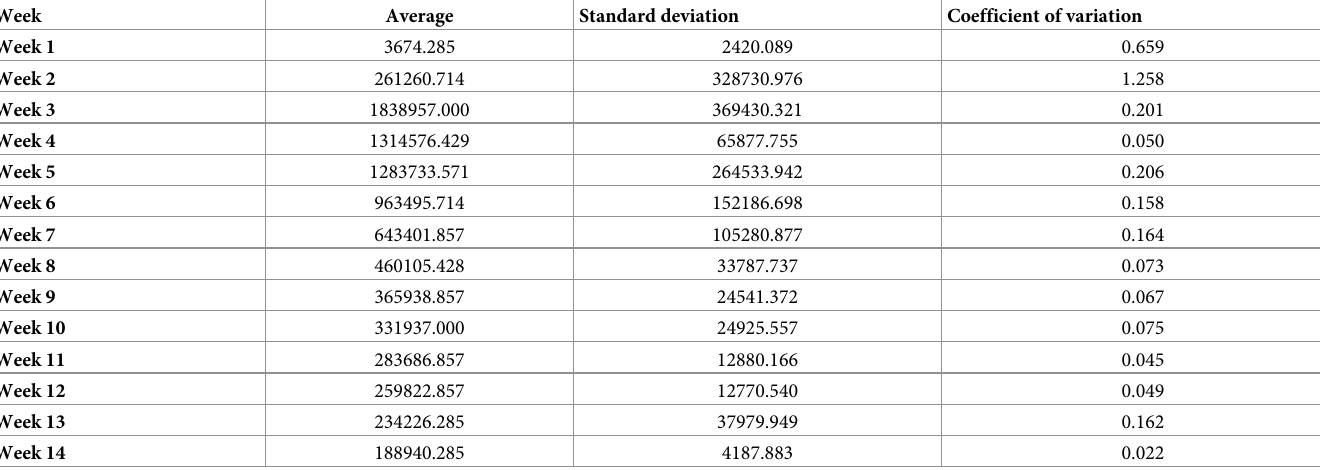
Table 1. 2020 novel coronavirus network variations from January 9 to April